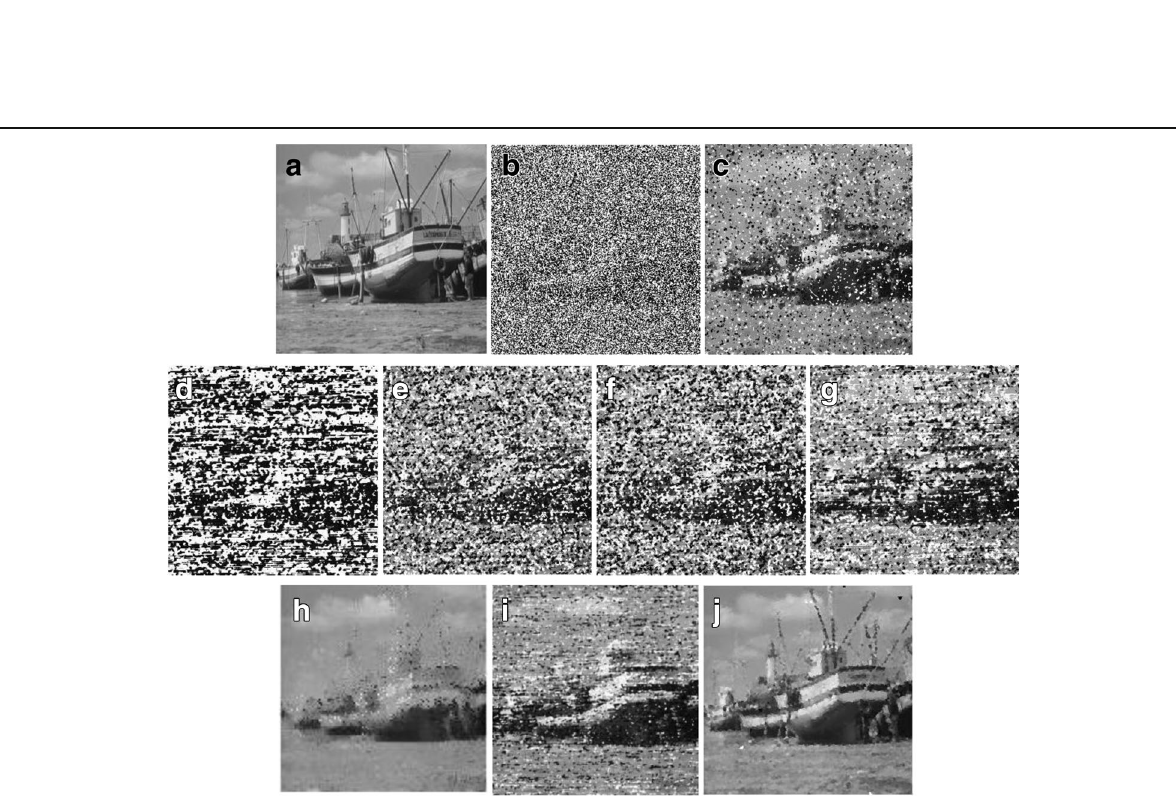
Fig. 7 Restoration results of different methods for Boat image corrupted with 80% noise density. Legends: a Boat (original image); b noisy image (80%); c NAFSWM; d ROAD; e ROLD; f TBLI; g ASM; h CBD; i AFIDM; and j